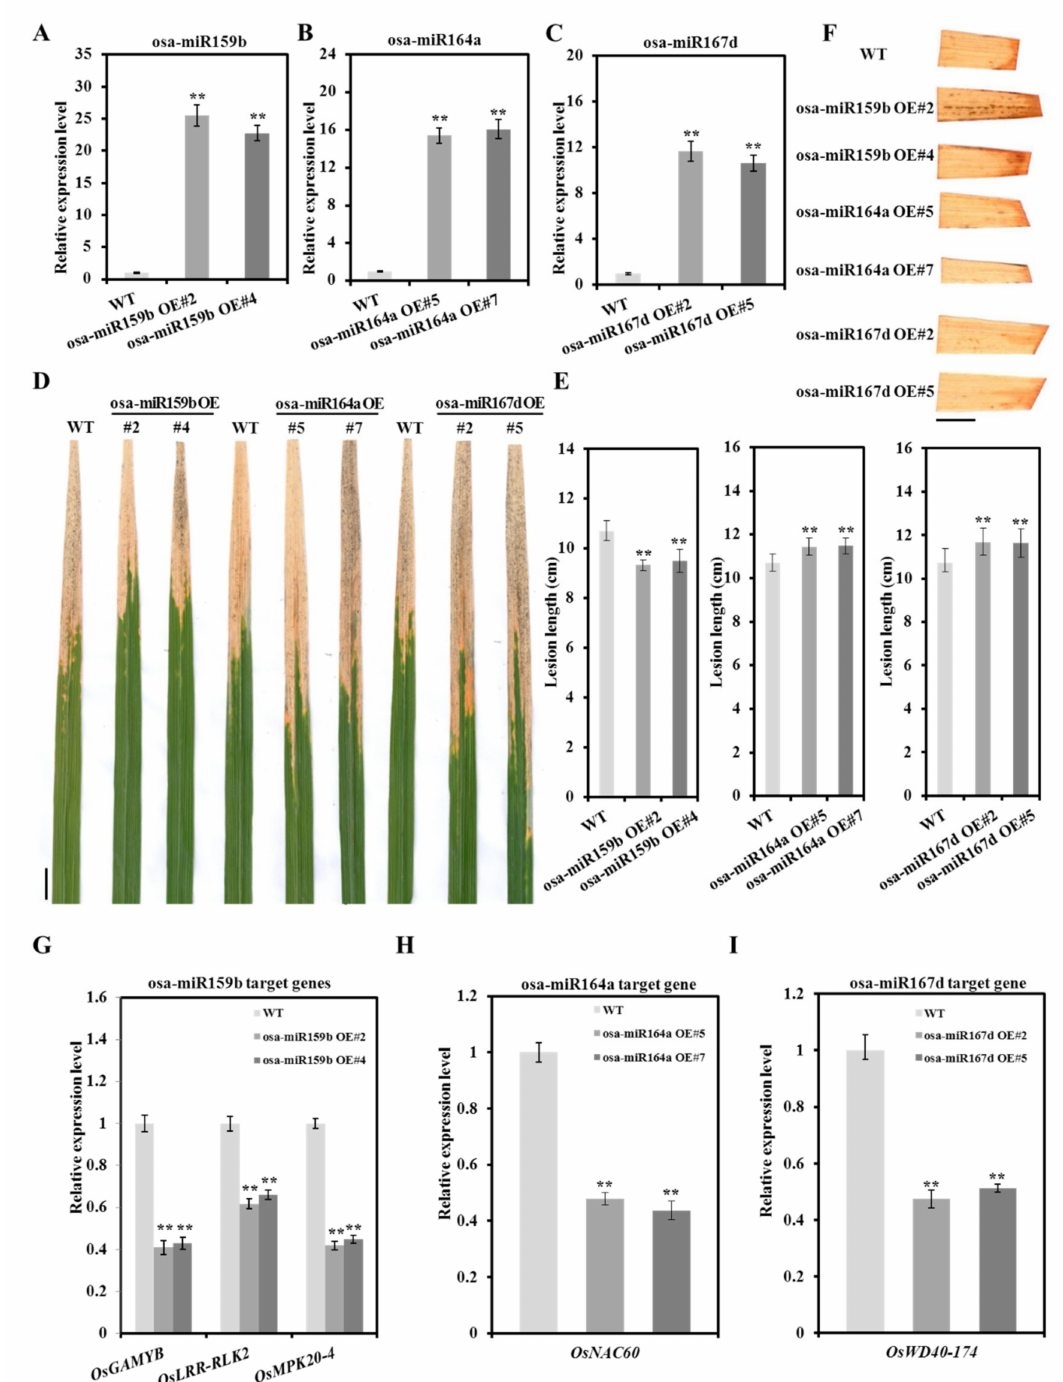
Figure 7. Multiple disease phenotype mediated by osa-miR159b, osa-miR164a and osa-miR167d-5p in overexpressing transgenic plants. ( A – C ) The excessive accumulation of osa-miR159b, osa-miR164a and osa-miR167d-5p in overexpressing transgenic lines. The wild-type (WT) Taipei 309 was used as control. ( D and E ) Diverse disease phenotypes caused by the Xoo strain PXO86 in di ff erent overexpressing transgenic lines. Lesion lengths for 45 diseased leaves in 15 plants were statistically analyzed at 14 dpi. ( F ) The histochemical detection of H 2 O 2 using 3,3 (cid:48) -diaminobenzidine (DAB) staining in WT and overexpressing transgenic lines after Xoo infection. Scale bar, 1 cm. ( G – I ) The relative expression levels of targets in overexpressing transgenic lines. Bars represent mean ± standard deviation ( n = 3 independent biological replicates). Asterisks indicate a statistically significant di ff erence (student t -test, ** p < 0.01, * p <